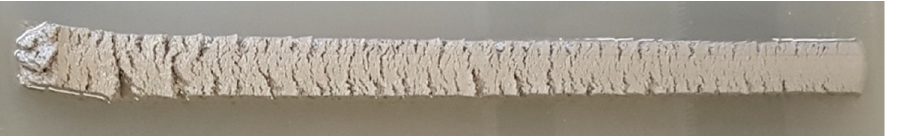
Figure 5. Parts additively manufactured underwater with a spindle shaft rotation speed of 15 rpm.